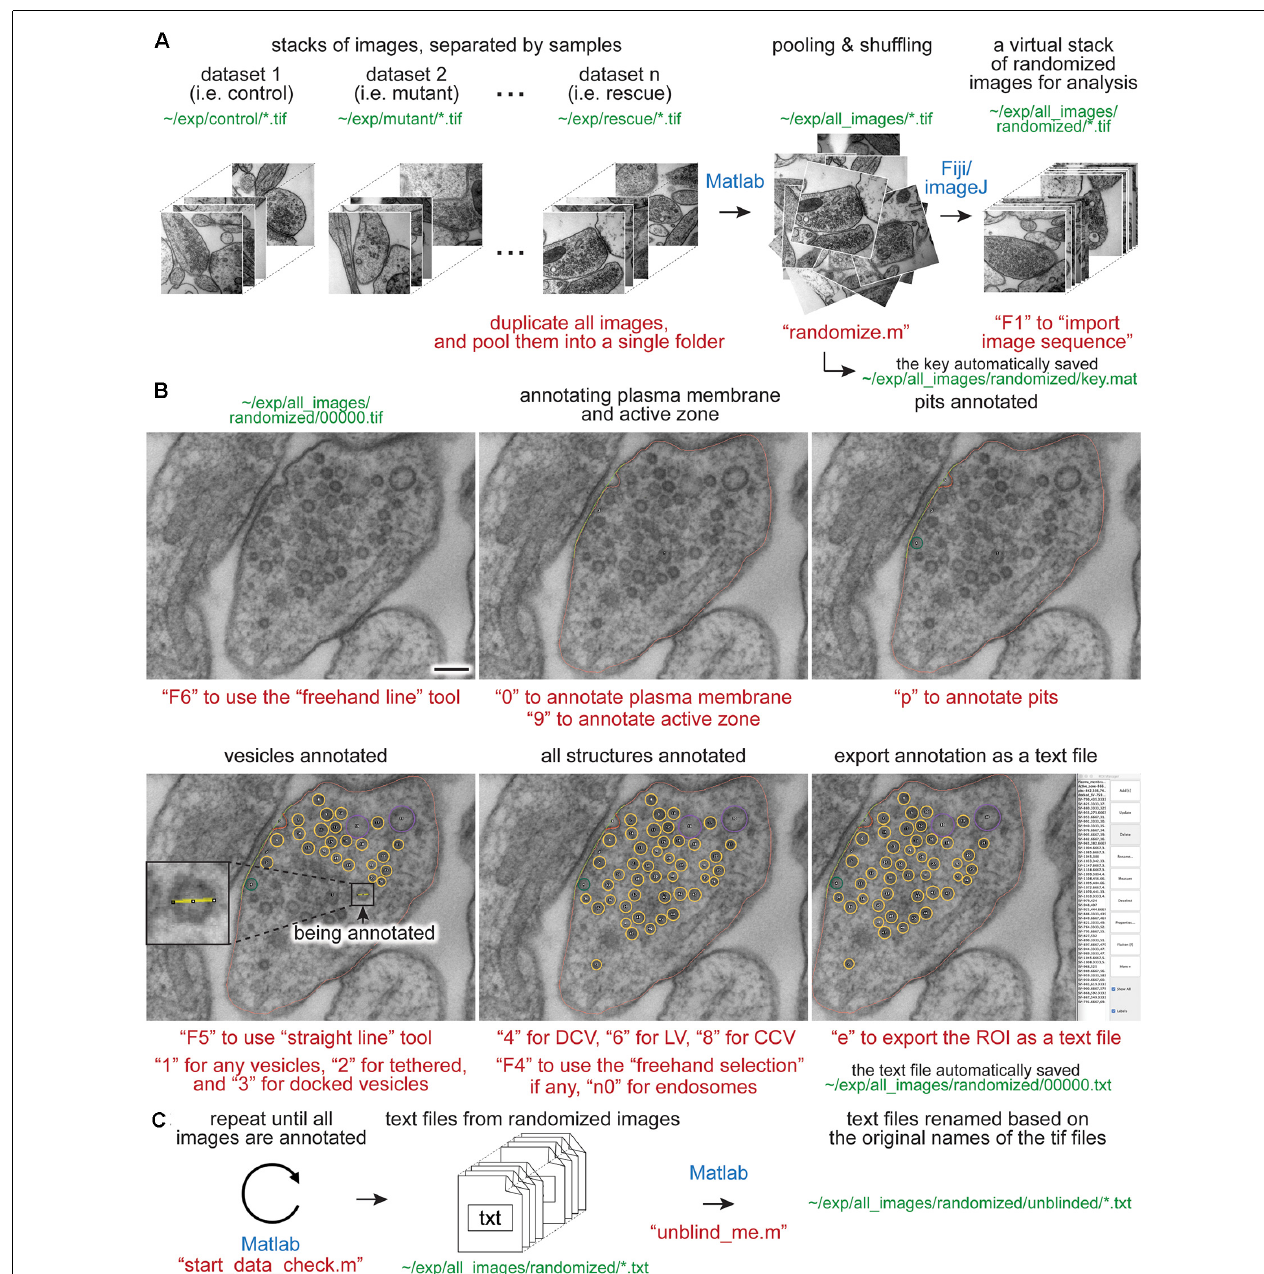
FIGURE 1 | Synapse morphometry using synapsEM. (A) A schematic showing the image randomization procedure. In each experiment, images are collected from multiple samples (i.e., control, mutants, drug-treated). Ideally, image acquisition should also be done blinded. These images are pooled into the same folder and then randomized using the “randomize.m” Matlab script. Running this program creates a new folder, named “randomized,” and transfers the images into this folder with the randomized number assigned to each image. These images should be opened in ImageJ or Fiji as a virtual stack using the F1 key after installing the “synapsEM_analysis_macro.txt” macro. (B) A schematic showing the procedure for image annotation. After opening the images in ImageJ/Fiji, membranes can be traced using specific tools and hot keys (as denoted in red). Note that all structures annotated are recorded into the ROI manager. For vesicles, draw a line across the vesicle membrane as shown in the inset. After pressing a hot key corresponding to the structure (i.e., “1” for synaptic vesicle in this case), the macro draws a circle using the drawn line as a diameter for the vesicle. When the annotation is complete, the structures listed in the ROI manager can be exported by simply pressing “e” on the computer keyboard. (C) A schematic showing the final steps of the morphometry. After all images in the dataset are annotated, the resulting text files must be first checked for errors using the “start_data_check” script in Matlab. After corrections, the text files can be decoded based on the original names of the corresponding images using the “unblind_me” script. This script duplicates the text files, decode the copied files, and move them to the “unblinded” folder. The decoded text files can be further processed for analysis. The sentences in red, green, and blue indicate the commands, the directory of files, and the software used, respectively. Scale bars = 100